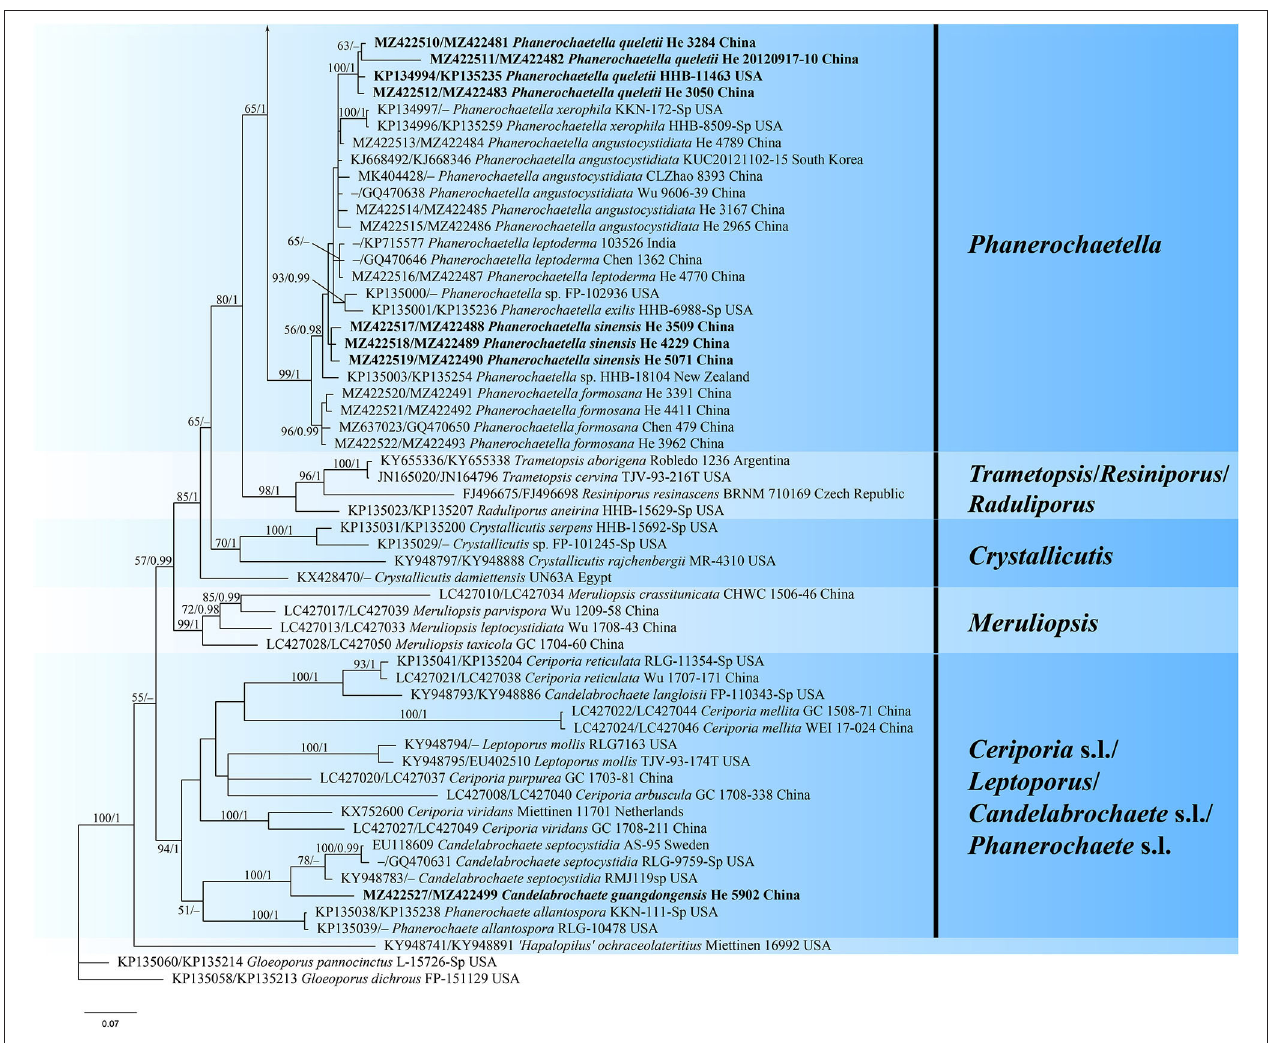
FIGURE 1 | Phylogram of Irpicaceae inferred from Bayesian inference using the concatenated ITS-nrLSU sequences dataset. Branches are labeled with likelihood bootstrap values ( ≥ 50%, before the slash) and Bayesian posterior probabilities ( ≥ 0.95, after the slash). New species and new combinations are set in bold.